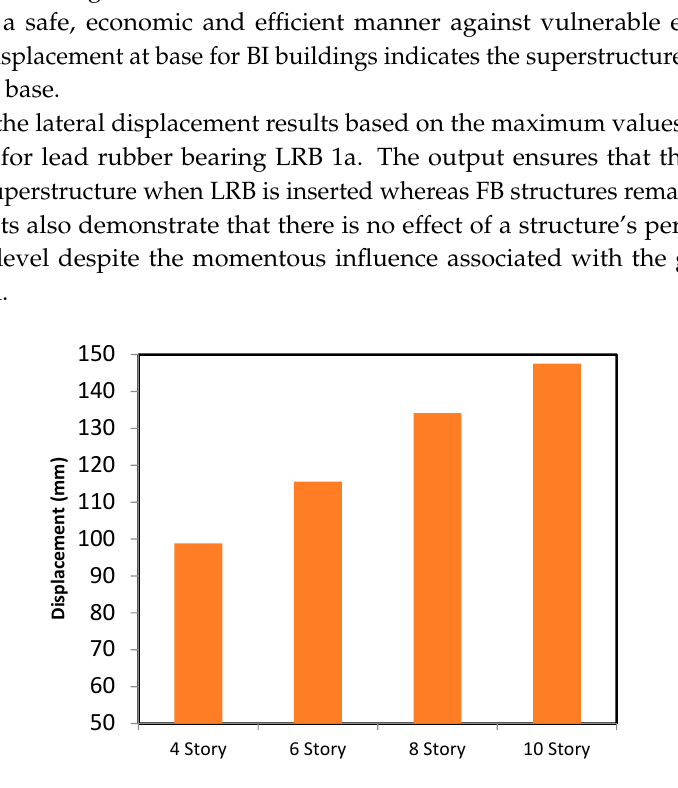
Figure 8. Variation of shear coefficient and displacement at 10-story building base.